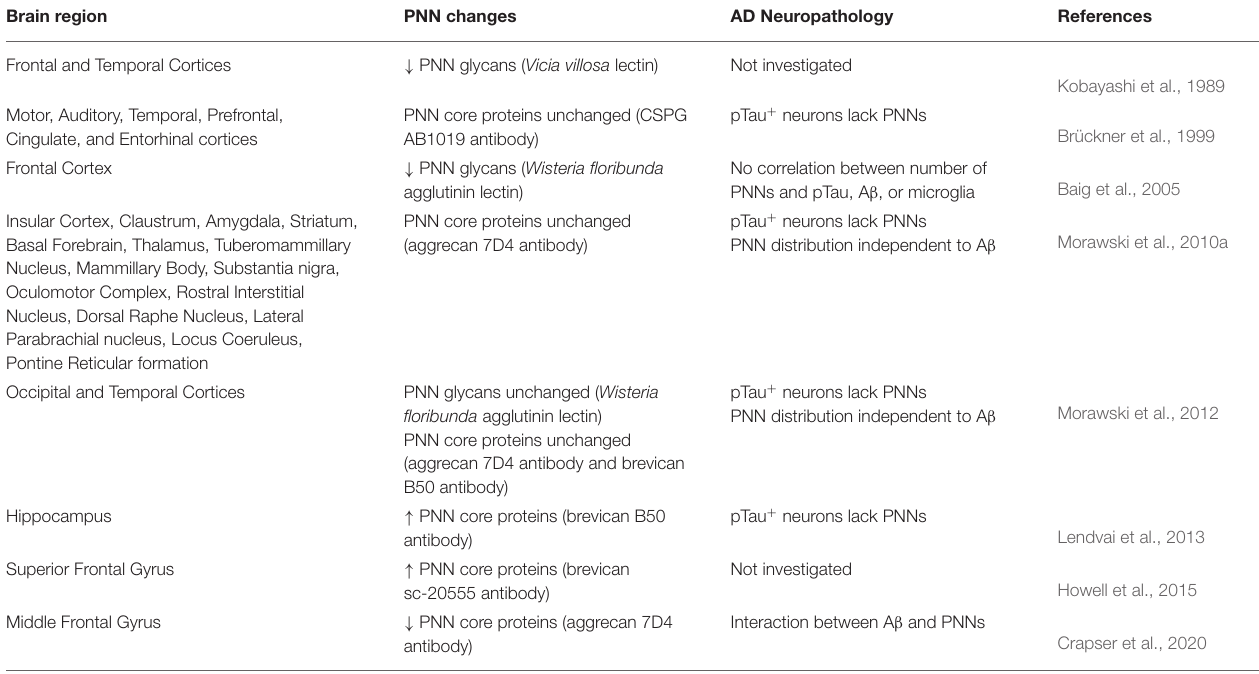
TABLE 1 | PNN changes in postmortem Alzheimer’s disease brain tissue. Brain